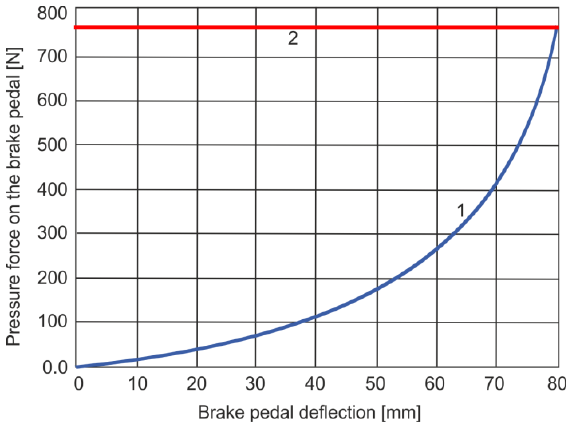
Figure 3. Pressure force related to brake pedal deflection during emergency braking: 1–pressure force of driver’s feet, 2–pressure force of the pneumatic actuator.